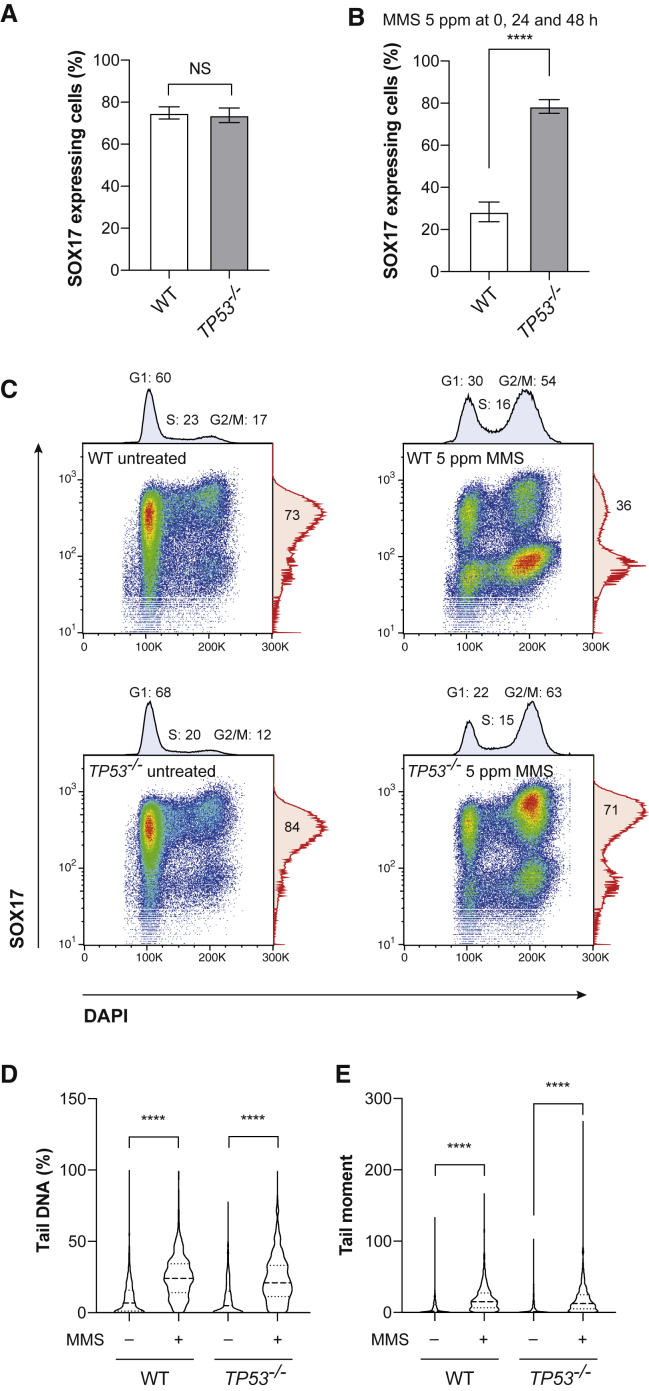
Loss of TP53 Rescues DE Differentiation after DNA Damage(A) The percentage of cells expressing SOX17 at 72 h of differentiation in the wild-type (WT) and TP53−/− cell line. No difference in the efficiency of differentiation was seen between the two cell lines using an unpaired t test (p = 0.8126, n = 6 independent experiments, mean ± SEM is plotted).(B) WT and TP53−/− cell lines were treated with 5 ppm MMS at 0, 24, and 48 h into differentiation (when the medium was changed), and efficiency of treated cells was expressed as a percentage of untreated cells. Significance was calculated using an unpaired t test (∗∗∗∗p < 0.0001, n = 6 independent experiments, mean ± SEM is plotted).(C) WT and TP53−/− cells were differentiated either without treatment or with exposure to 5 ppm MMS at 0, 24, and 48 h. Cells were collected at 72 h and monitored for SOX17 expression and cell-cycle phase using DAPI. The SOX17-positive proportion of cells and the proportion of cells in each phase of the cell cycle are shown. Cell-cycle quantification was calculated using the Dean-Jett-Fox model on FlowJo.(D) Alkaline comet analysis was performed on WT and TP53−/− differentiating cells. Cells were treated with or without 5 ppm MMS at 24 h and collected 2 h later for analysis (n = 2 independent experiments with >400 comets analyzed per condition; p values calculated with Kruskal-Wallis with Dunn's multiple comparisons test, ∗∗∗∗p < 0.0001).(E) As for (D) but showing tail moment, ∗∗∗∗p < 0.0001.